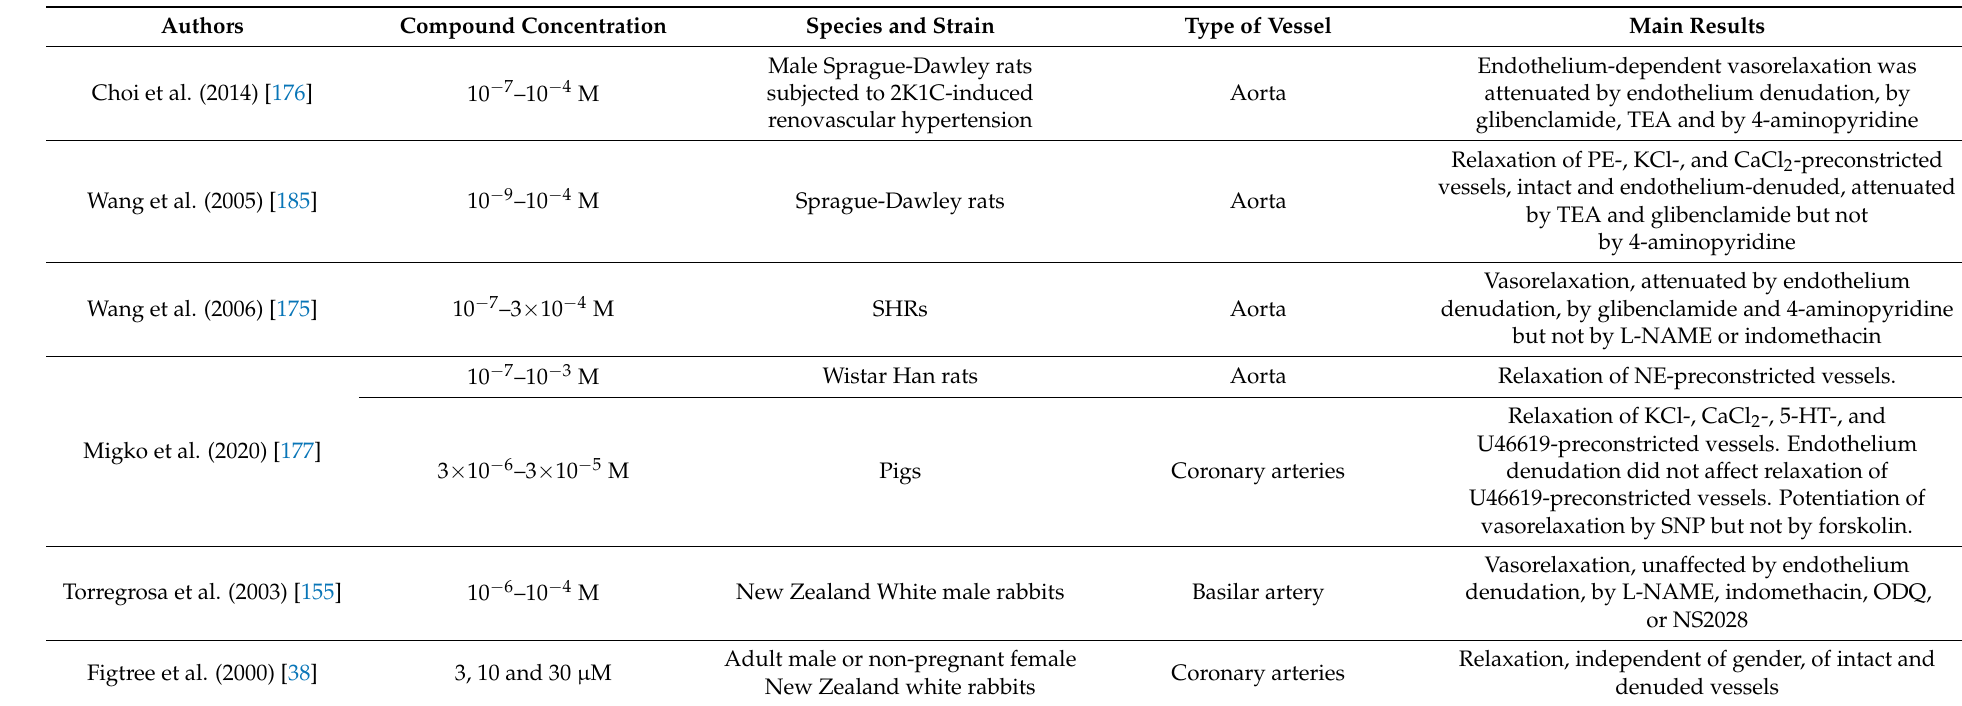
Table 5. Description and main results of in vitro studies on the vasorelaxant activity of biochanin